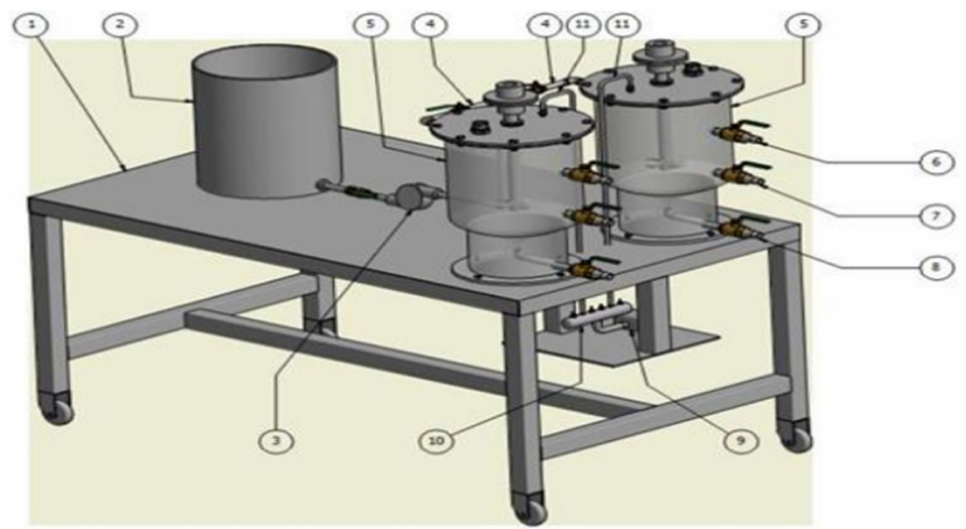
Figure 1. SBR isometric view: ( 1 ) table, ( 2 ) SBR holding tank, ( 3 ) centrifugal pump, ( 4 ) influent feed stream, ( 5 ) SBR vessel, ( 6 ) effluent sample point 1, ( 7 ) effluent sample point 2, ( 8 ) sludge discharge stream, ( 9 ) aerator pump, ( 10 ) manifold, and ( 11 ) oxygen aerator pipe